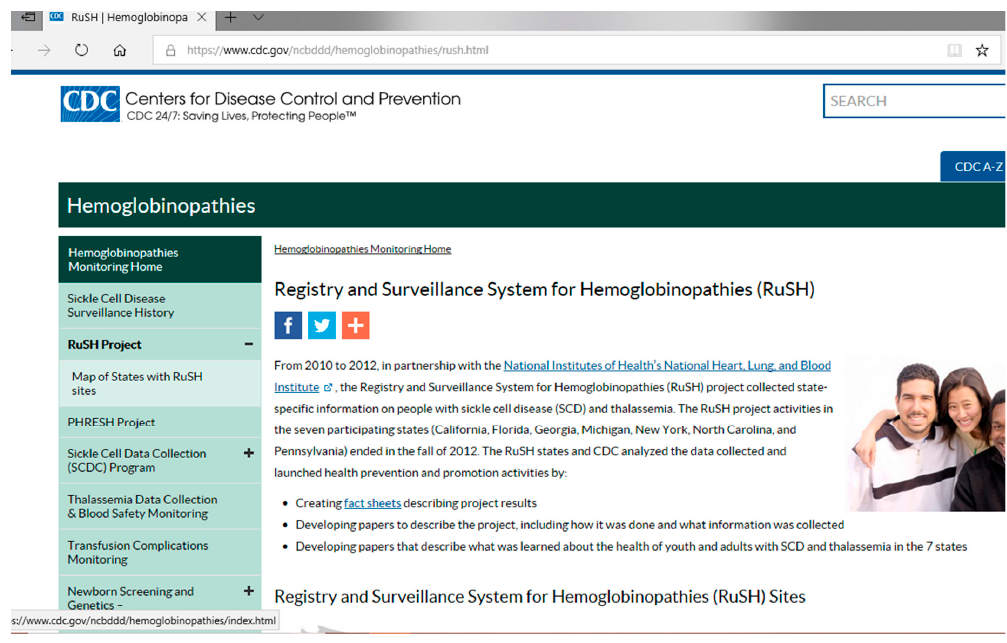
Figure 1. Website of the Registry and Surveillance System for Hemoglobinopathies (RuSH). The web page includes listing of the public health programs on hemoglobinopathies at the Centers for Disease Control and Prevention.